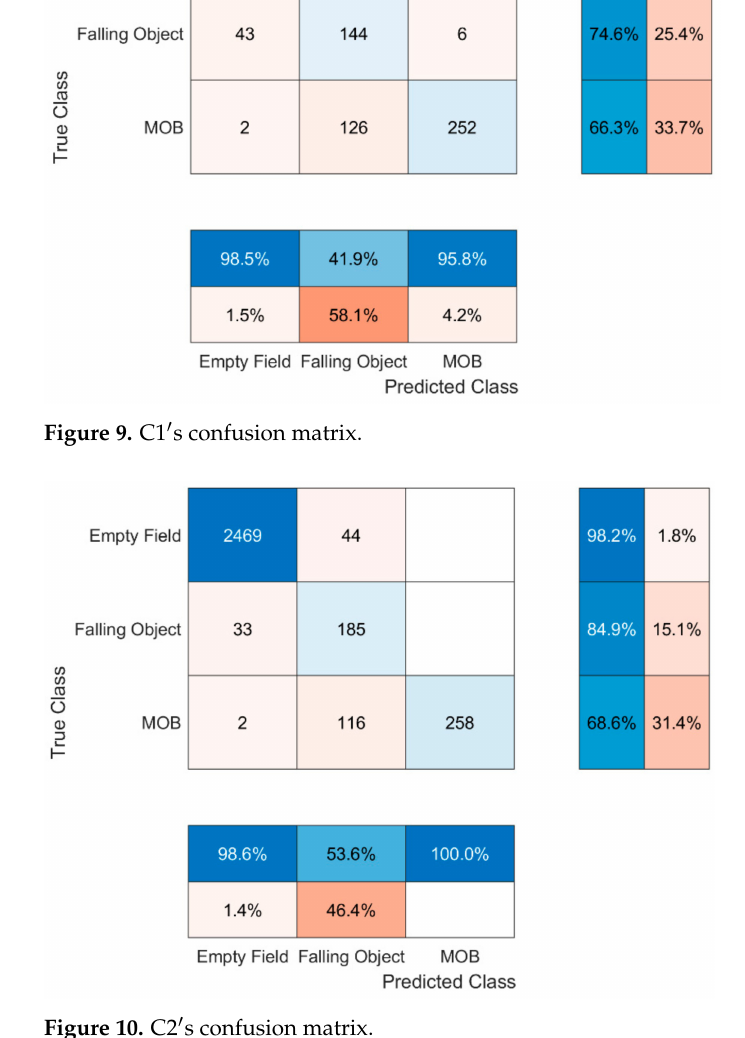
Figure 10. C2 (cid:48) s confusion